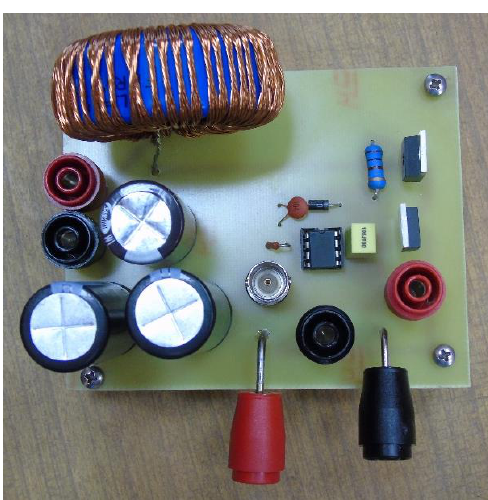
Figure 5. Diagram of the tested boost converter.